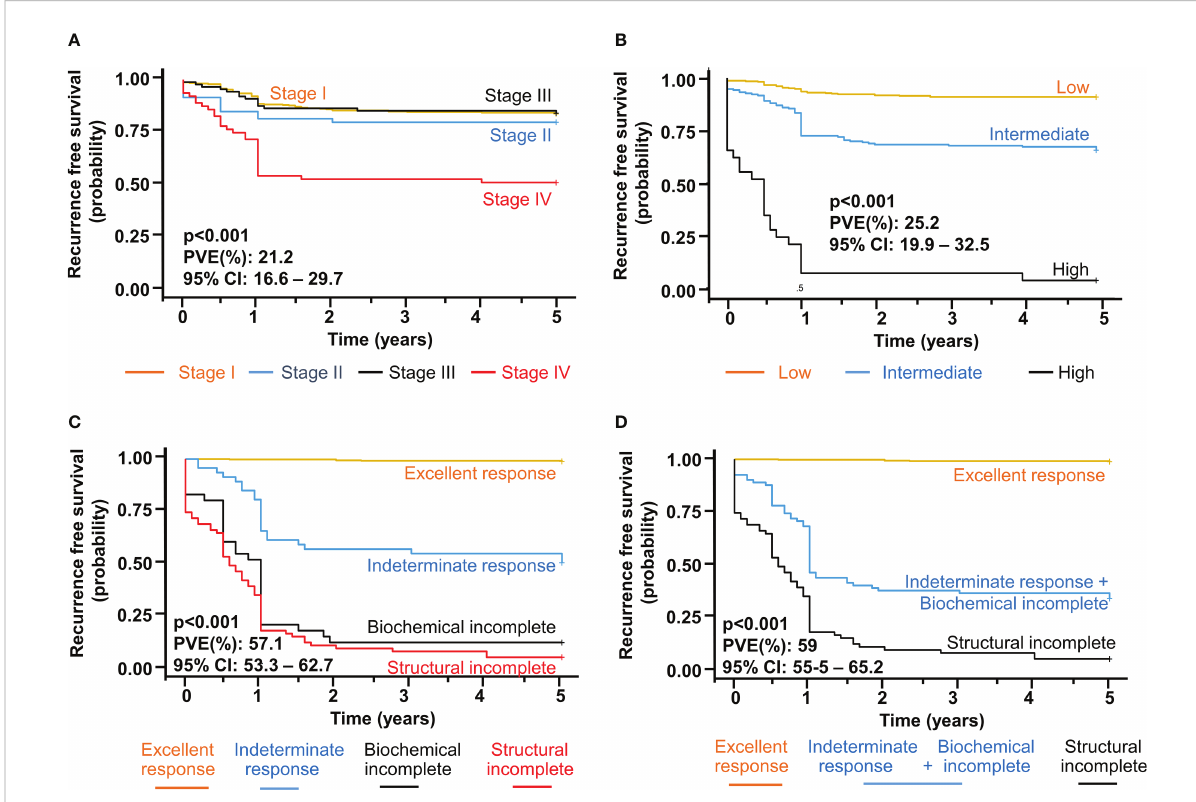
FIGURE 1 Recurrence Free Survival (RFS) and proportion of variance explained (PVE) to assess the performance of (A) seventh AJCC TNM stage, (B) ATA risk system, (C) 4-tiered dynamic risk strati fi cation (DRS) and (D) 3-tiered DRS (integrating indeterminate and biochemical incomplete). Adjusted Hazard Ratios with 95% con fi dence intervals (95% CI) were calculated in logistic regression model. A two-tailed P value less than 0.05 was considered statistically signi fi cant.